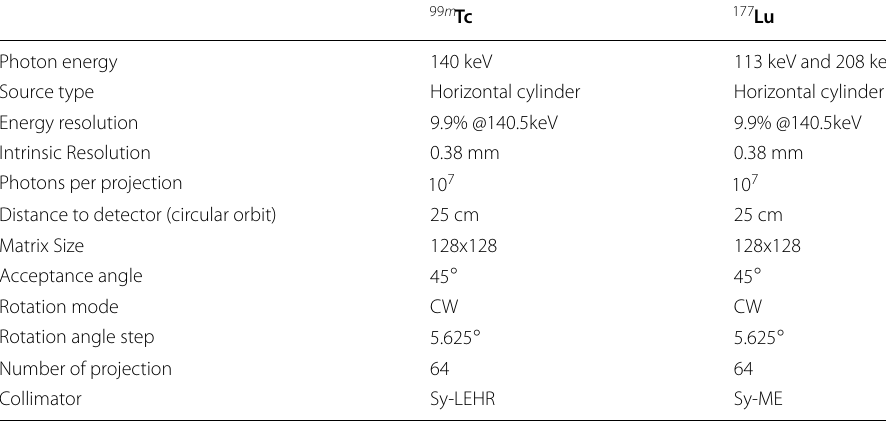
Table 6 Main parameters inserted in SIMIND’s CHANGE program for horizontal cylinder uniformly filled with radionuclides activity 99 m Tc 177 Lu Photon energy 140 keV